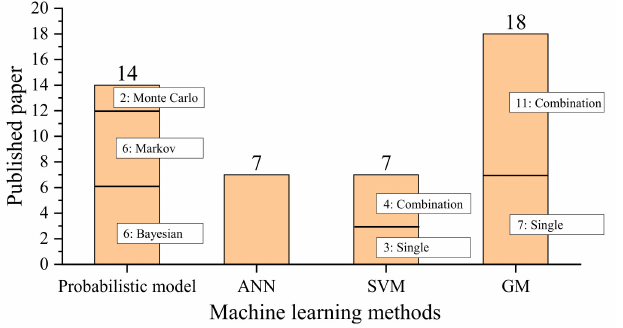
Figure 8. Statistical analysis for existing machine learning methods for track degradation